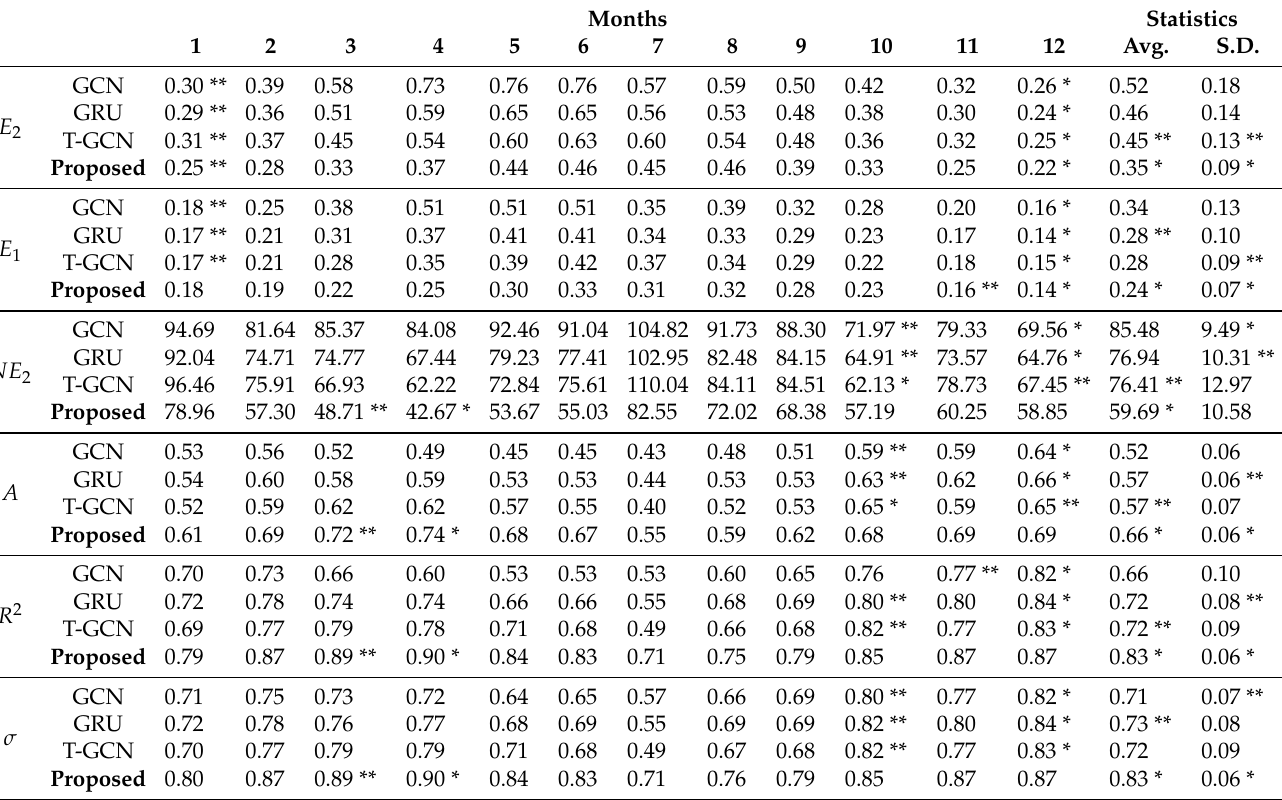
Table 5. Performance of the proposed and existing models according to months. In the third to fourteenth columns, * and ** indicate months when each forecasting model had the best and second- best performances, respectively. Additionally, in the last two columns, * and ** denote forecasting models that showed the best and second-best performances on average and the lowest and second- lowest standard deviation, respectively. The hyper-parameters were set as L o = 24, L p = 24, N = 4, and θ V =